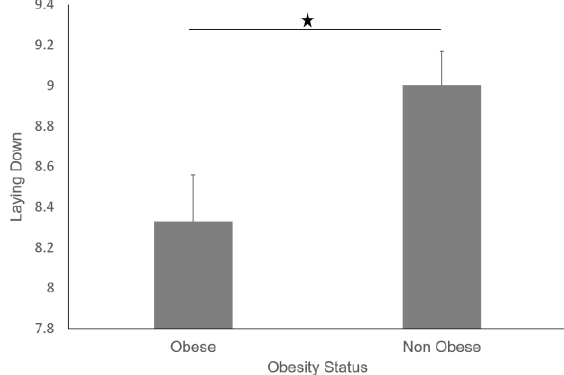
Figure 19. Total number of transitions in obese and non-obese individuals at night.